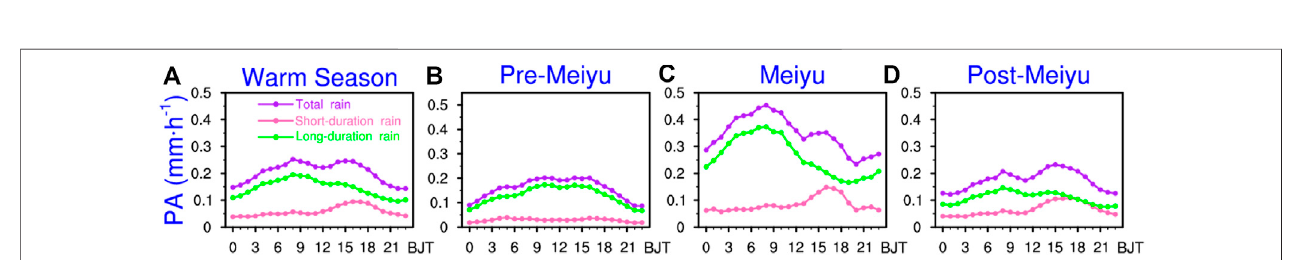
FIGURE 10 | Diurnal cycles of total PA and PA with different duration regionally averaged over Jiangsu in warm season and each sub-period of warm season ( fi gures A-D separately represent Warm season, Pre-Meiyu, Meiyu and Post-Meiyu period) over 2013 – 2017.